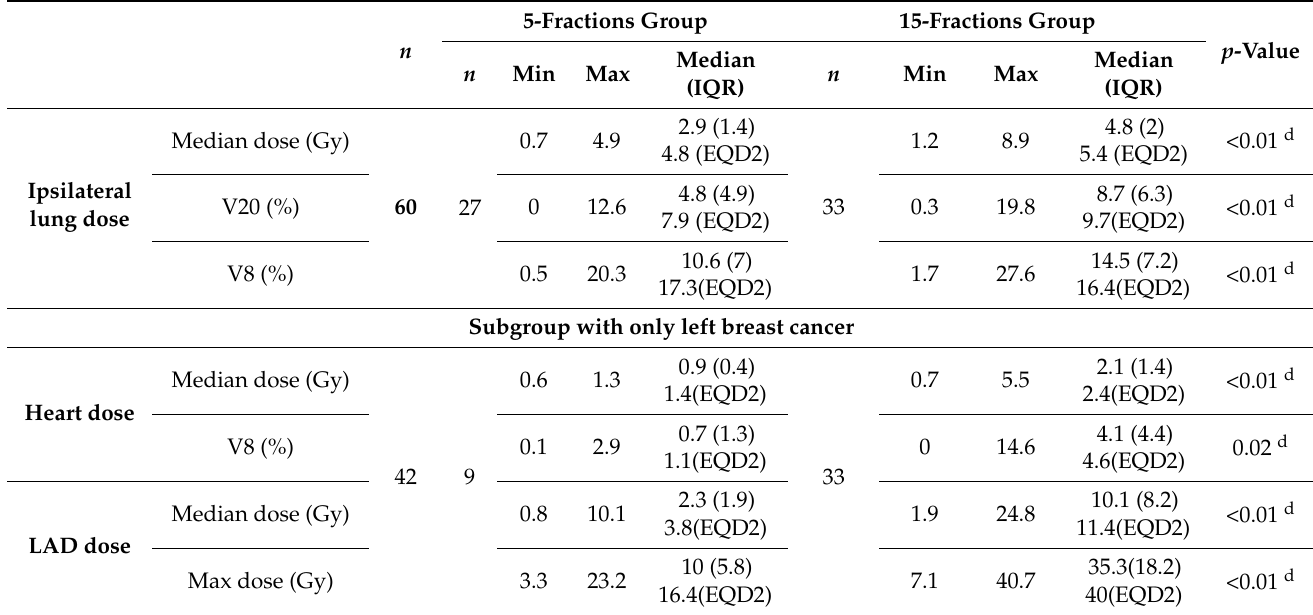
Table 3. Comparison of dosimetric parameters between